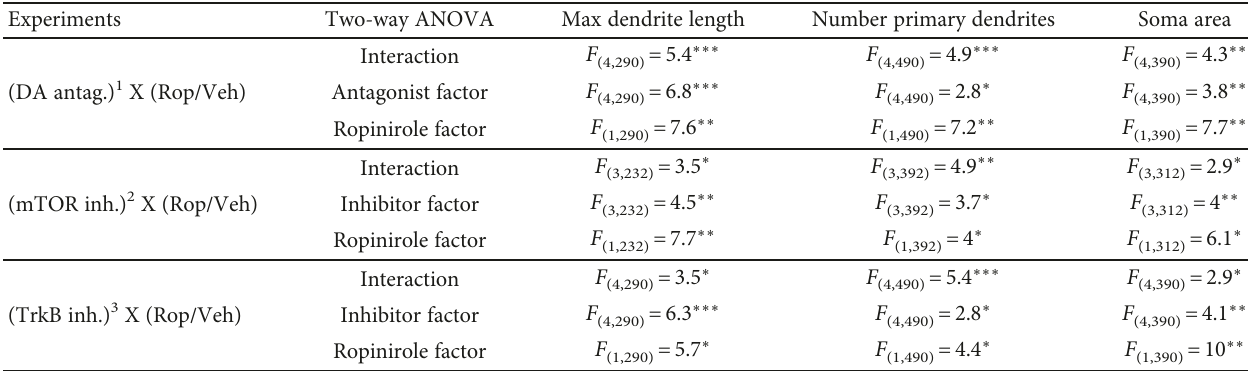
Table 1: Statistical analysis of the e ff ects produced by D3R antagonists, by MEK-ERK and PI3K-mTOR inhibitors, and by BDNF-TrkB signaling inhibitors on ropinirole-induced structural plasticity in F3 DA neurons. Experiments Two-way